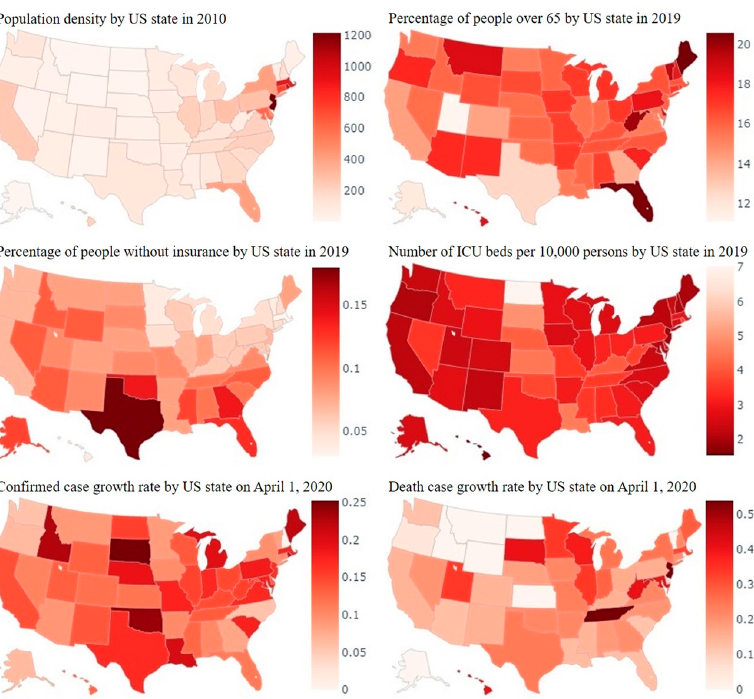
Figure 2. Some representative factors related to the severity of COVID-19 and their heterogeneous